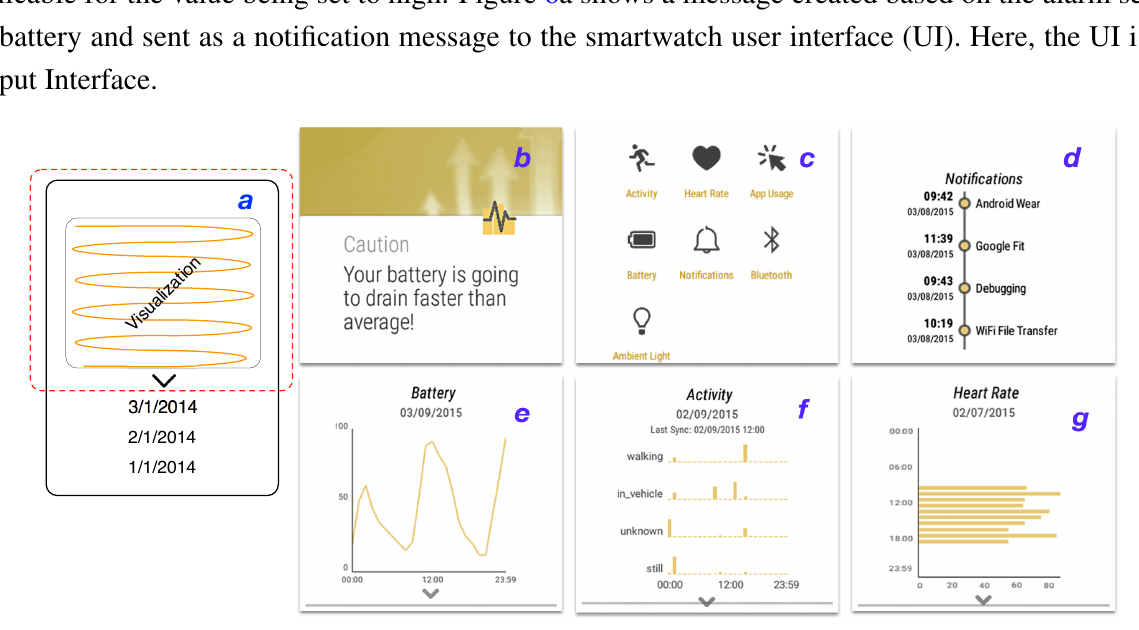
Figure 6. ( a ) The visualization pattern that is used for each sensor. The red area depicts the smartwatch screen. Previous days can be accessed through scrolling; ( b – g ) Some of the screens of the implementation of our framework designed for end-user